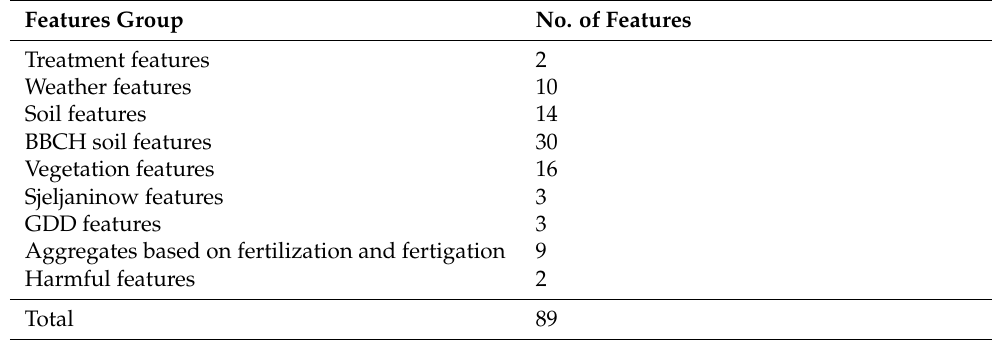
Table 3. Summary of all prognostic